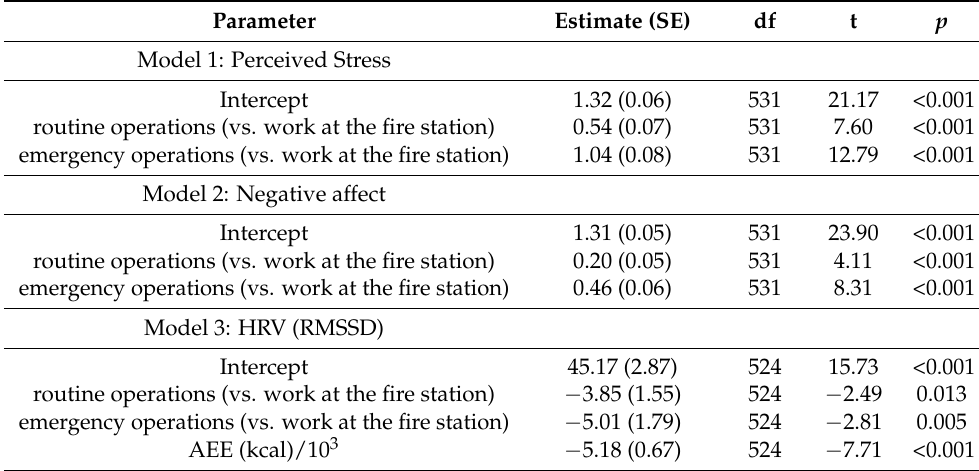
Figure 1. An adapted schematic representation of a dynamic AddHRVr algorithm from Schwerdtfeger and Rominger [5]. Table 1. Multilevel model for objective stress predicting perceived stress, negative affect, and HRV